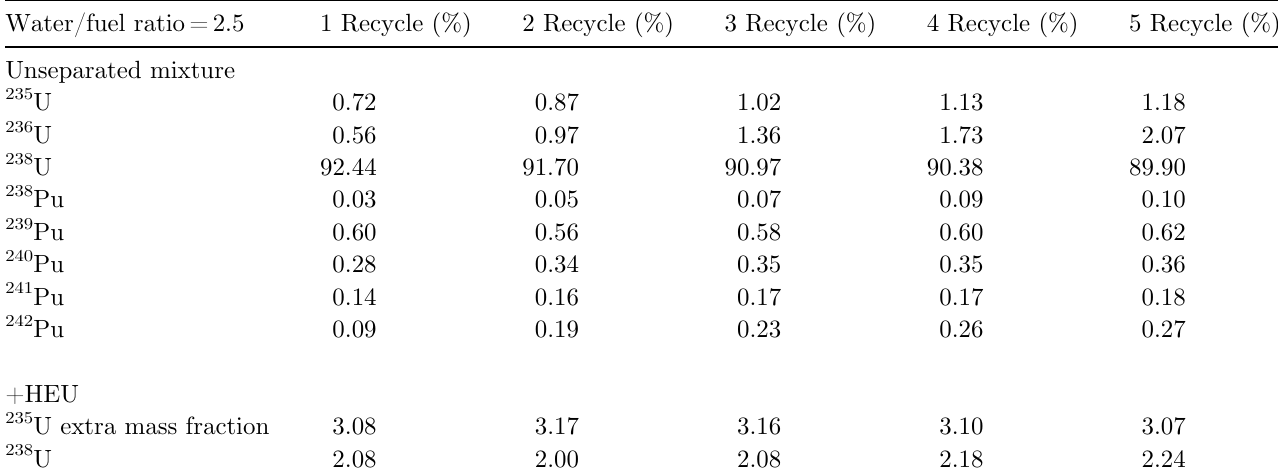
Table 3. REMIX fuel composition for FA with water/fuel ratio = 2.5. Water/fuel ratio =